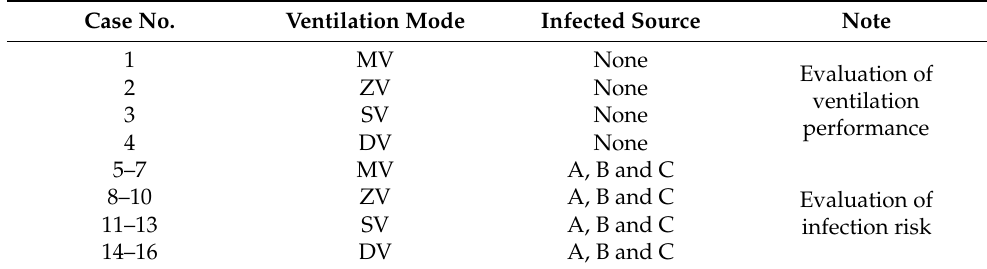
Table 3. Overview of simulation